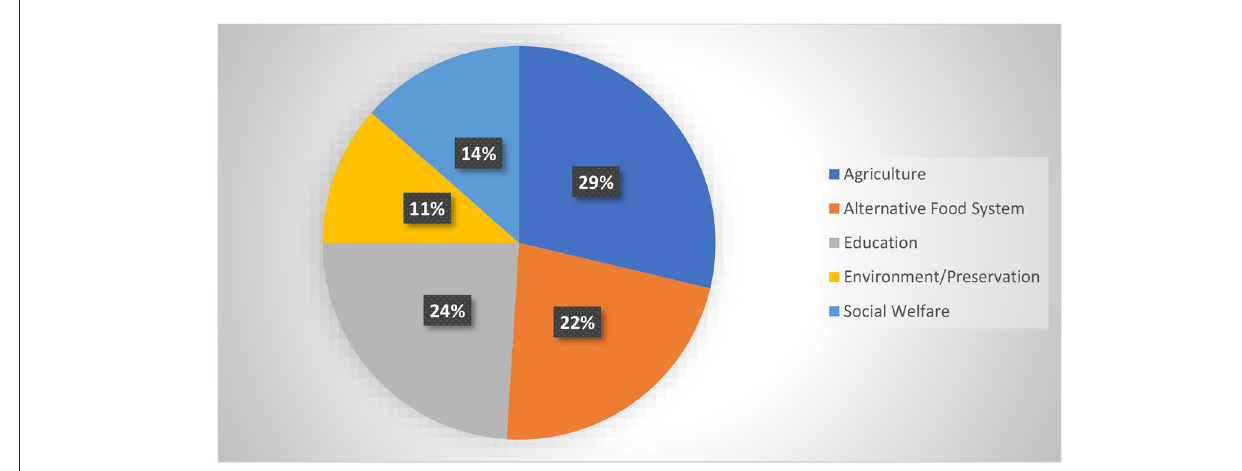
FIGURE3 Primary missions of US non-profit farms. Source: Analysis of GuideStar data.